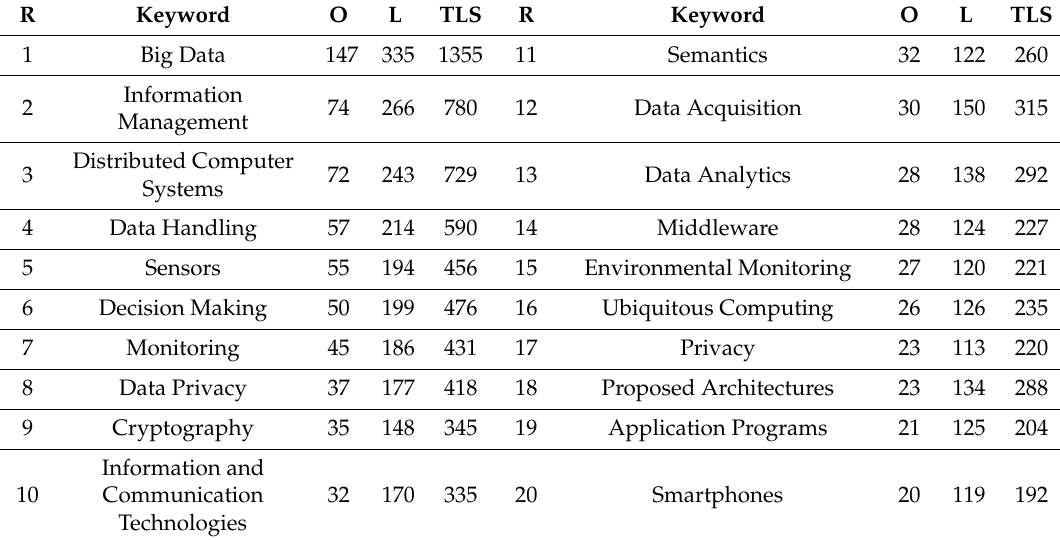
Table 4. Cluster 1: Top 20 keywords